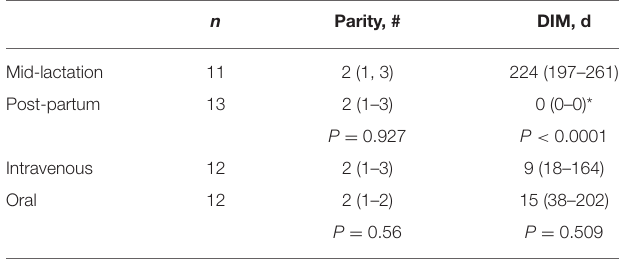
TABLE 1 | Distribution of cows matched based on parity and days in milk (DIM) after random allocation to meloxicam formulation administered. n Parity, # DIM,